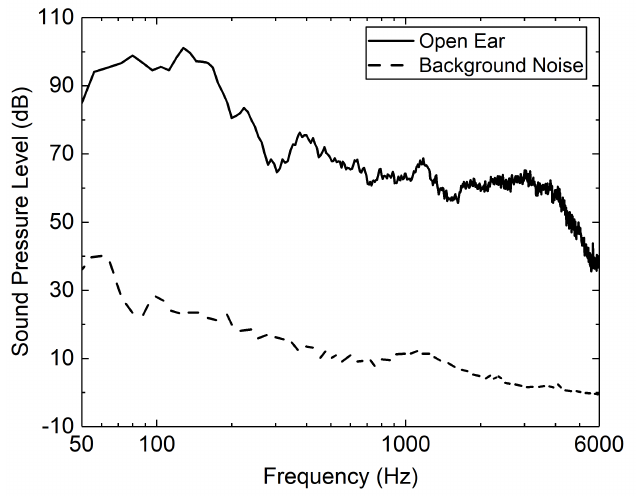
Figure 5. Time-averaged open ear sound pressure level of the aircraft take-off exterior noise and the background noise measured by the simulator in the reverberation chamber. Note that the frequency resolution is 8